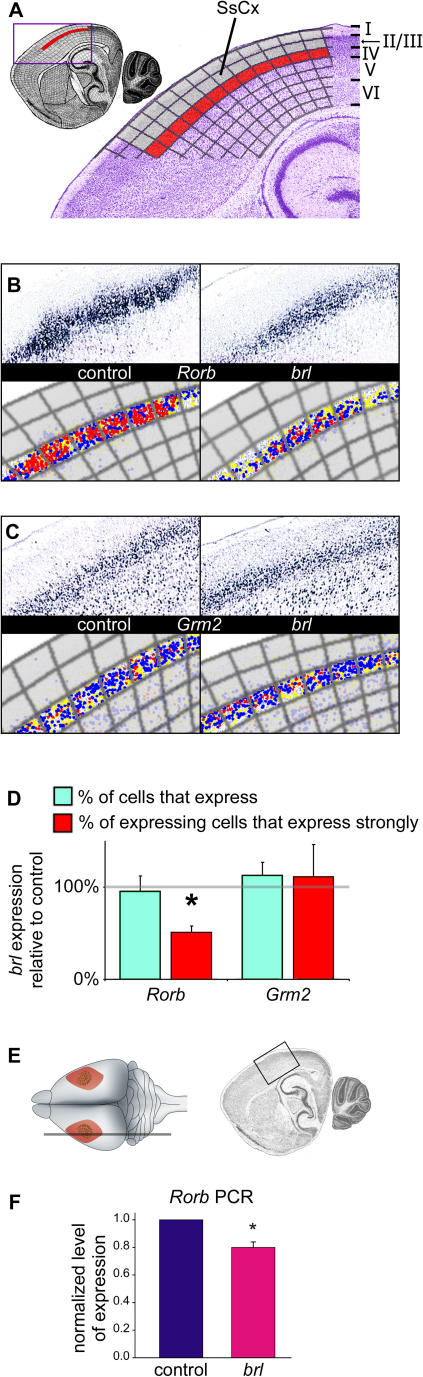
Quantitative Analysis of Rorb and Grm2 Expression in Control and brl P7 Brains(A) The dataset of 200 genes was searched using a query pattern defined as strong expression in layer IV of the somatosensory cortex (SsCx) (red) and no expression in layers I and II/III somatosensory cortex (grey) for standard section 2. Rorb and Grm2 were two of the top matches returned.(B) The strong expression Rorb in control somatosensory cortex layer IV coincides with the anatomical shape of the barrels that are absent in the brl mouse. For both genotypes, cellular expression was detected and color-coded by signal strength using the Celldetekt software, followed by fitting of the appropriate subdivision mesh to the shape of the cortex. A row of 12 quadrilaterals in the subdivision mesh defines the area of comparison in the somatosensory cortex layer IV. Note the greater prevalence of strongly expressing cells (red) in the control tissue. Moderately expressing cells and weakly expressing cells are indicated by blue and yellow, respectively.(C) Quantification of Grm2 expression in somatosensory cortex layer IV as described for Rorb showed no difference in expression strength distribution between control and brl.(D) Statistical comparisons between control and brl revealed no significant changes in the percentage of somatosensory cortex layer IV cells expressing either Rorb (p = 0.8) or Grm2 (p = 0.5). However, a significant decrease in the percentage of strongly expressing cells was found for Rorb in brl (p = 0.02), but not for Grm2 (p = 0.8).(E) The somatosensory cortex containing the barrel region was dissected as indicated (highlighted and boxed) and used for quantitative real-time PCR analysis.(F) Consistent with the ISH data, a statistically significant decrease in Rorb expression was found in brl by quantitative real-time PCR (p = 0.008).